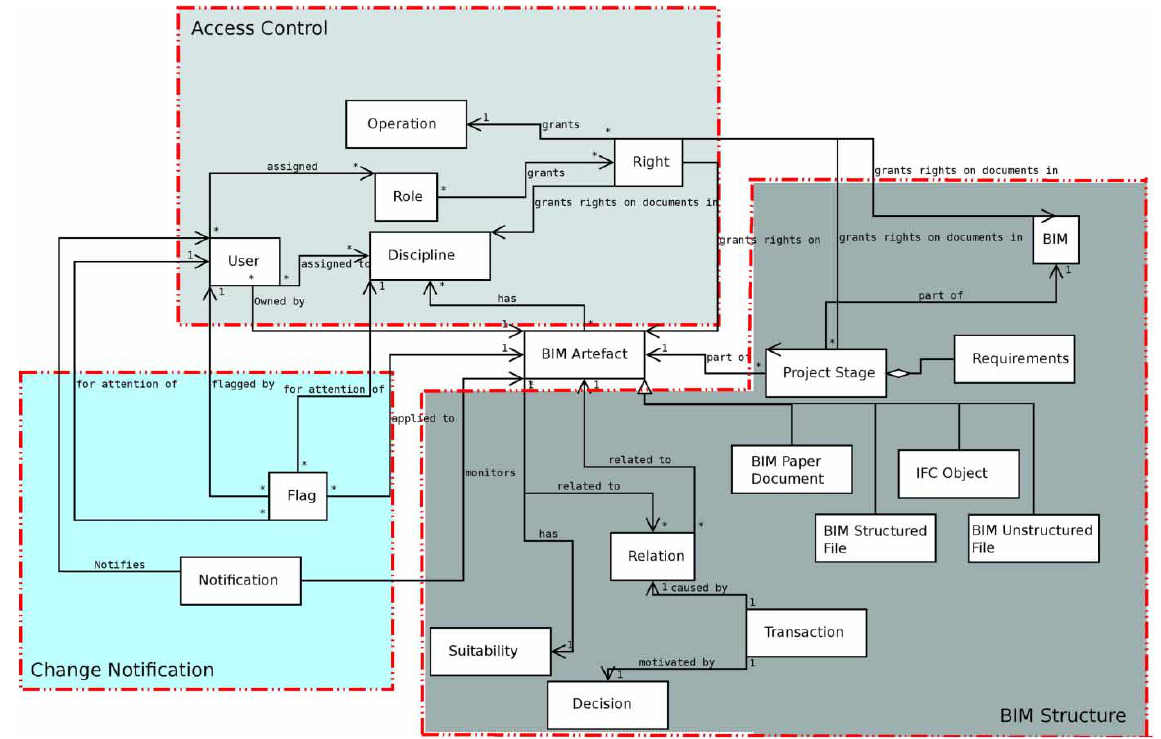
Fig. 9. Overall view of the governance